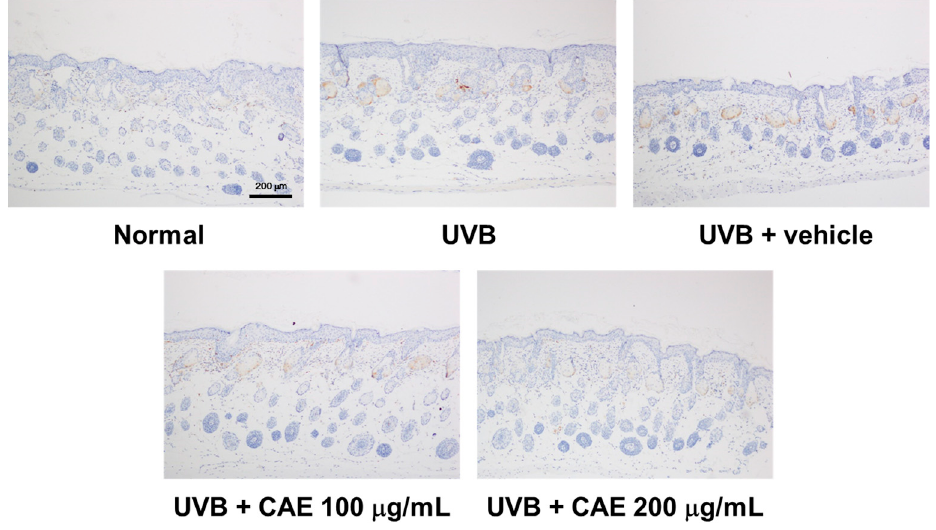
Figure 18. Immunohistological staining for iNOS in the hairless mouse skin after UVB exposure and CAE treatment.